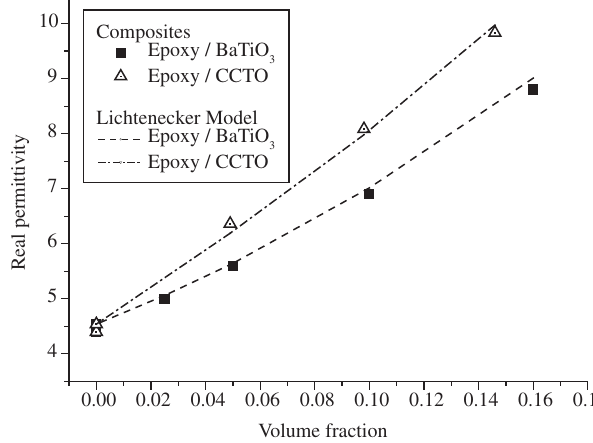
Figure 5. Real Permittivity as a function of volume fraction of CCTO and